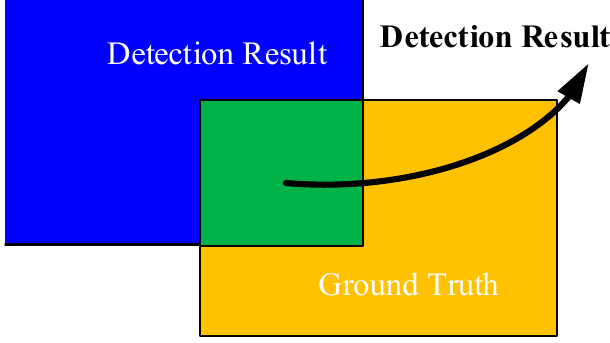
Figure 4. The Conception of the Interview over Union (IoU).